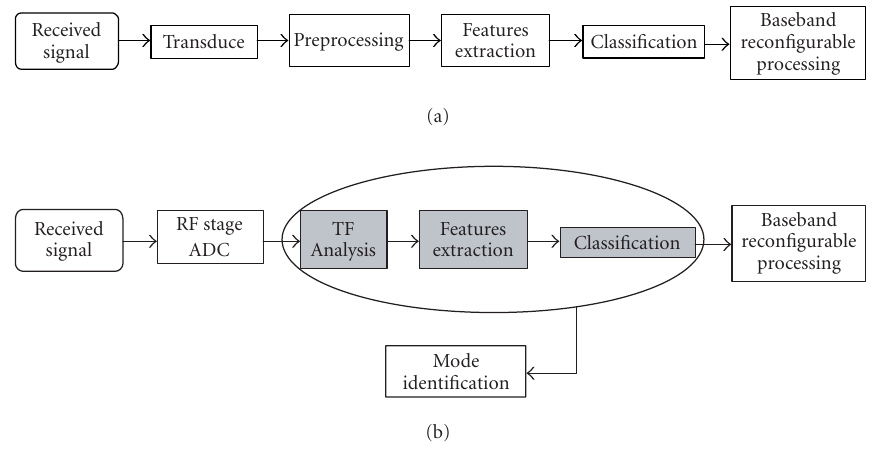
Figure 1: A general classification scheme and the proposed method for mode